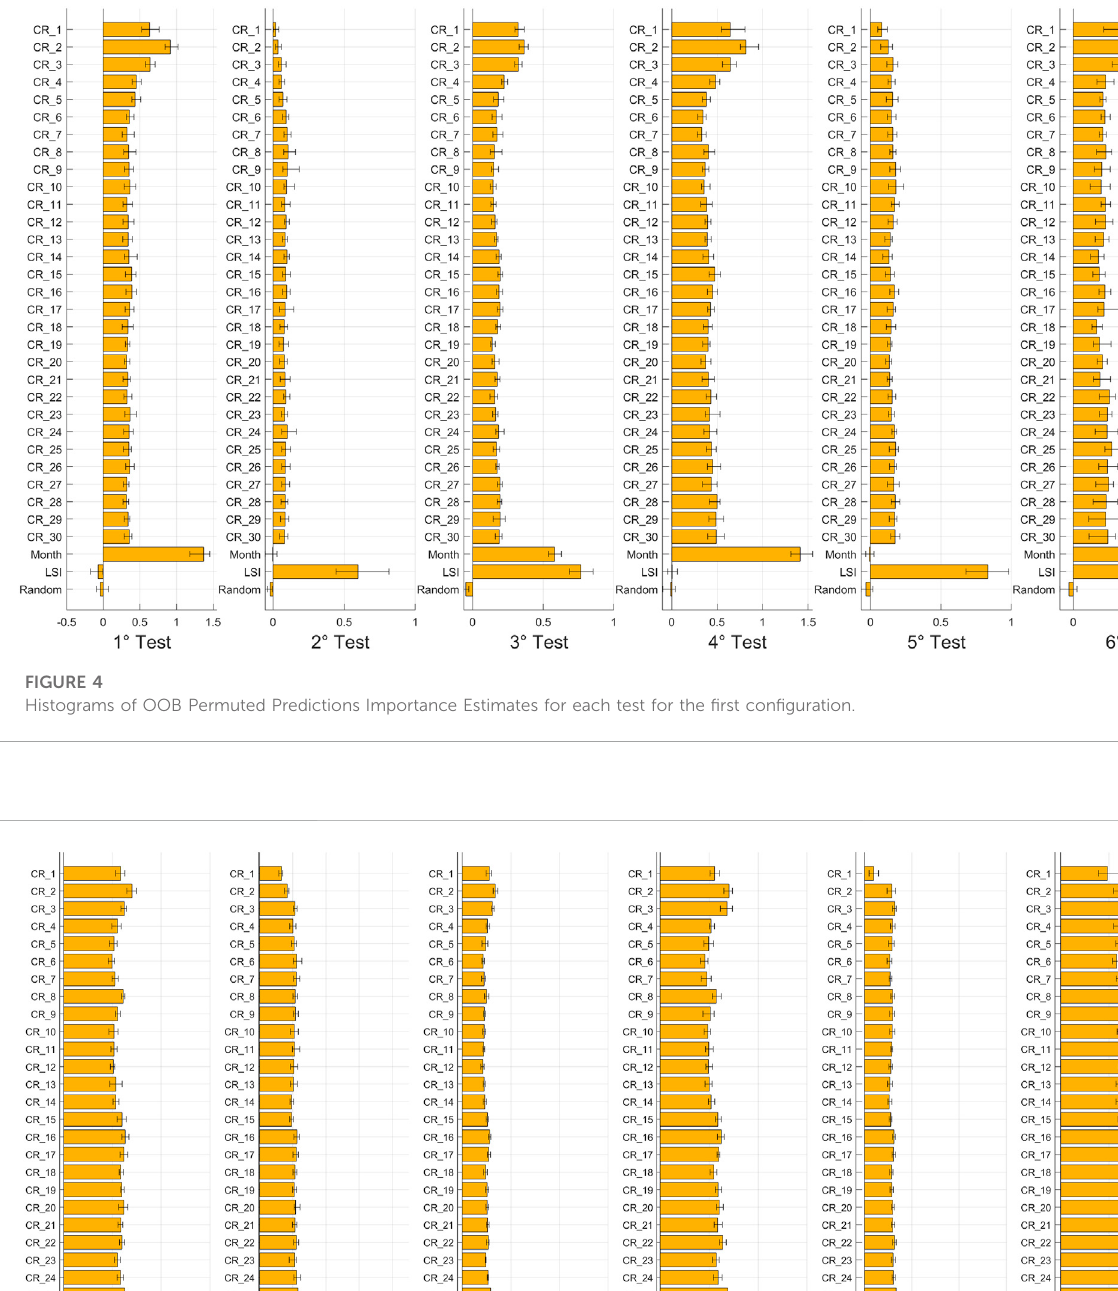
Frontiers in Earth